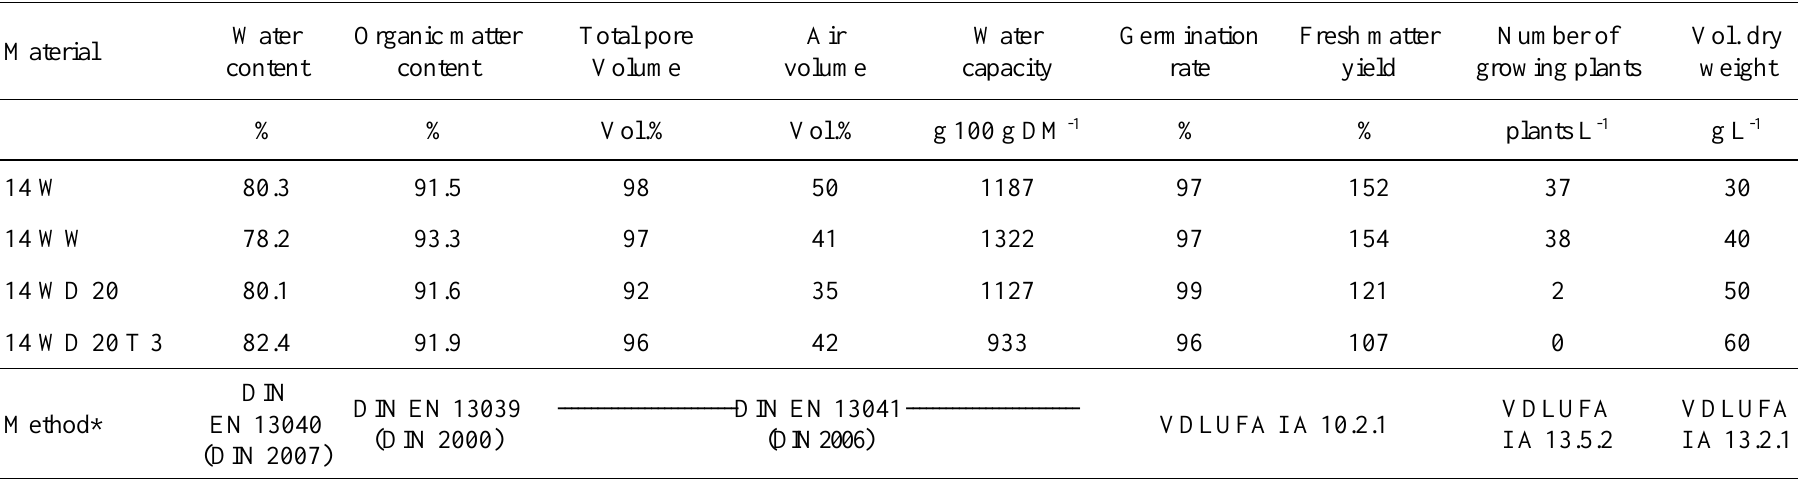
Table 2. Results of vapour treatment for Sphagnum papillosum grown at the research site in Ramsloh (referred to as wet material).